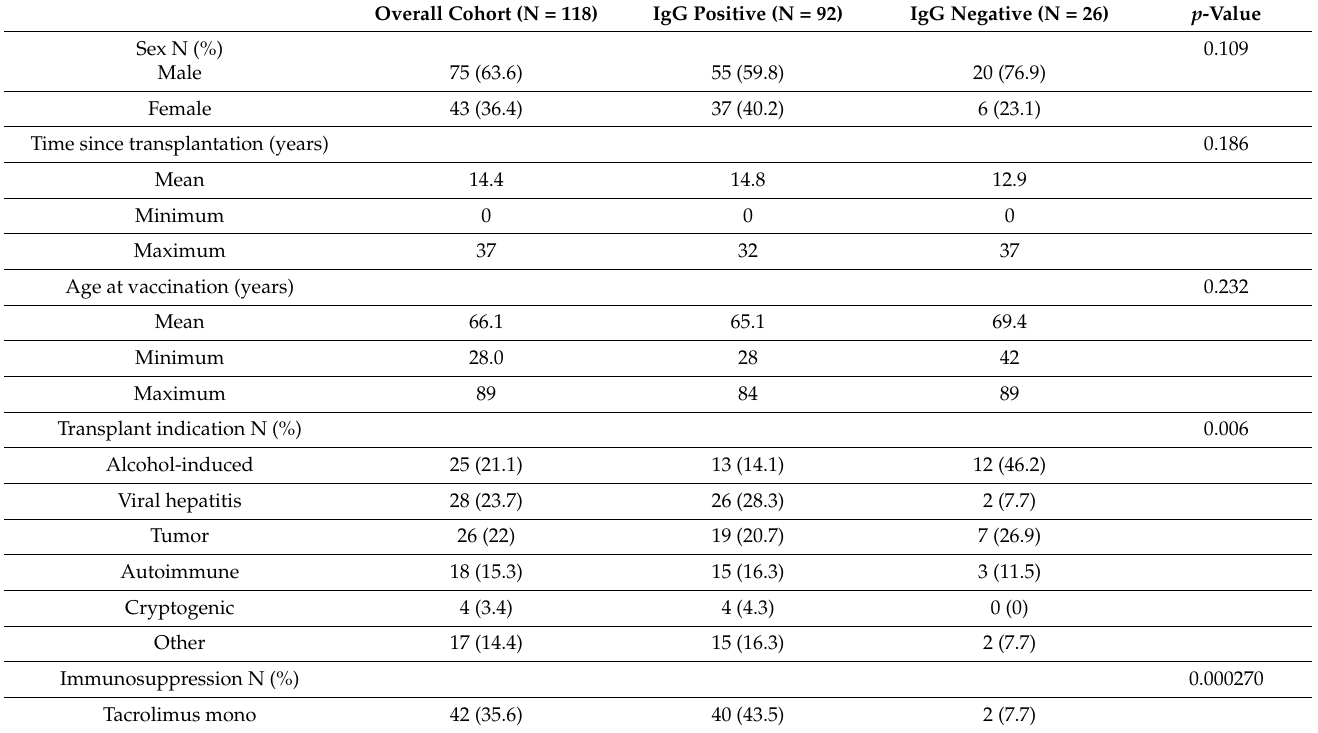
Table 1. Patients’ characteristics in the overall